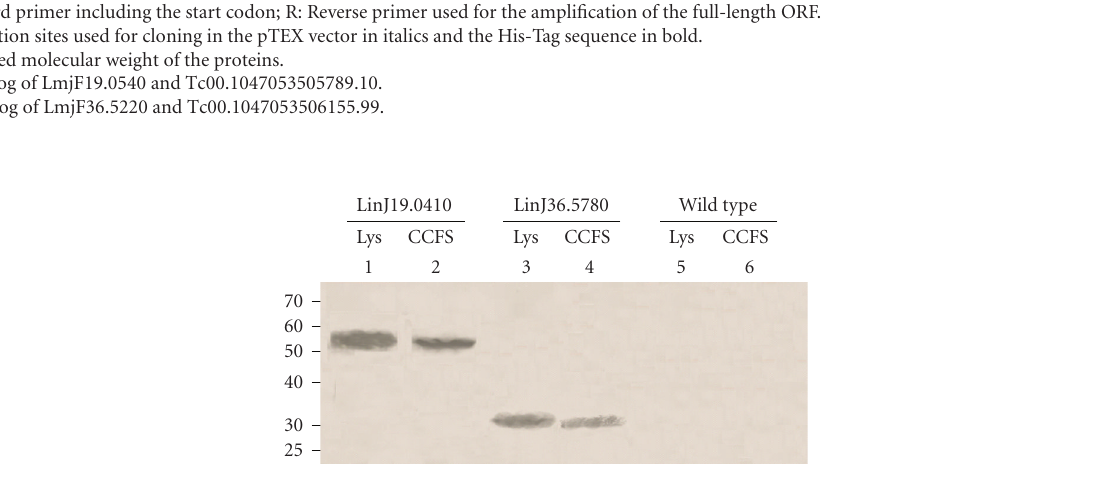
Figure 4: Homologous expression of secreted proteins in L. infantum episomally transfected promastigotes. L. infantum pro- mastigotes were transfected with genes LinJ19.0410 and LinJ36.5780 corresponding to secreted proteins Tc00.1047053505789.10 and Tc00.1047053506155.99, respectively. Cell whole lysate (Lys) and concentrated cell-free culture supernatant (CCFS) and electrophoresis procedure were as in Figure 3. Tagged proteins were detected only in recombinant parasites transfected with LinJ19.0410 (58 kDa) (Line 1 and 2) and LinJ36.5780 (28 kDa) (Line 3 and 4). Nontransfected L. infantum promastigotes (Wild Type) were used as negative controls (Line 5 and 6). Protein molecular mass standards in kDa are shown on the left.